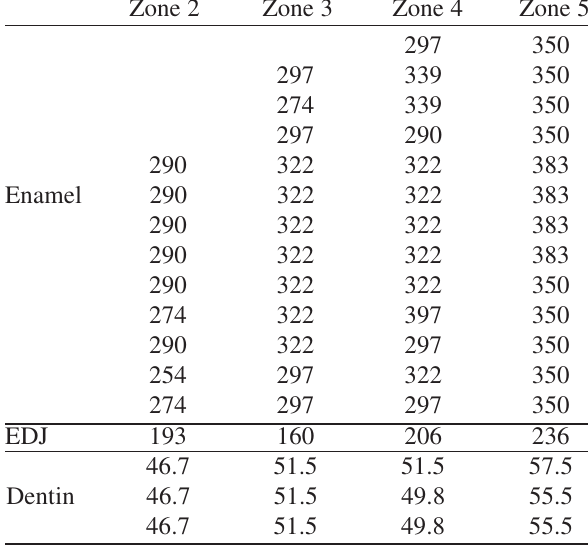
Table 3. Main VHN values for the five zones from the 7 samples analyzed. Zone 1 (cervical) was not included because its very small thickness allowed only few good indentations (always less than four). The value for EDJ represents indentations in enamel, 20 µ m away from the junction.